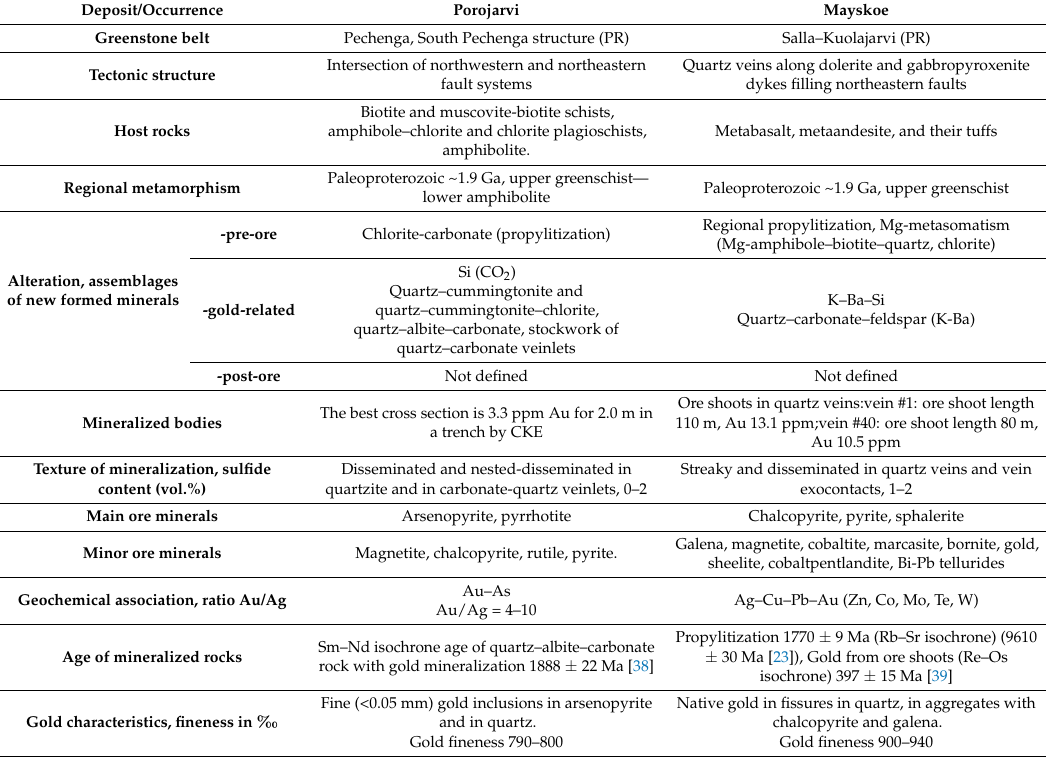
General characteristics of gold occurrences in the Pechenga and Salla–Kuolajarvi greenstone